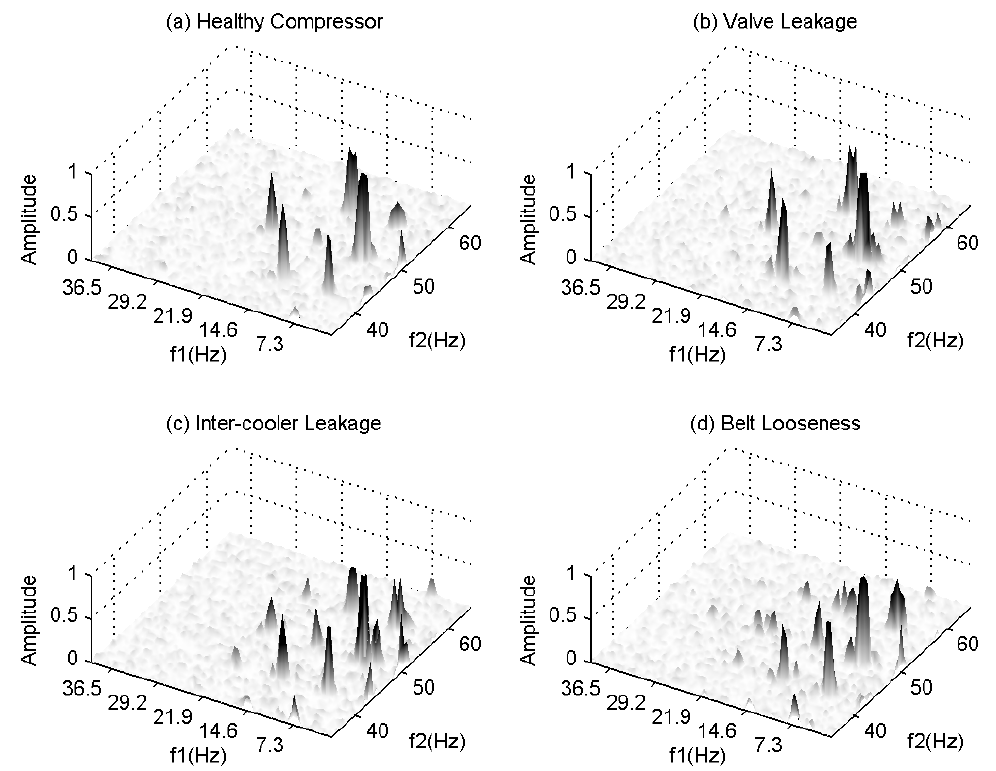
ff erent conditions of the reciprocating Figure 13. MSB coherences for different conditions of the reciprocating compressor. Figure 13. MSB coherences for di